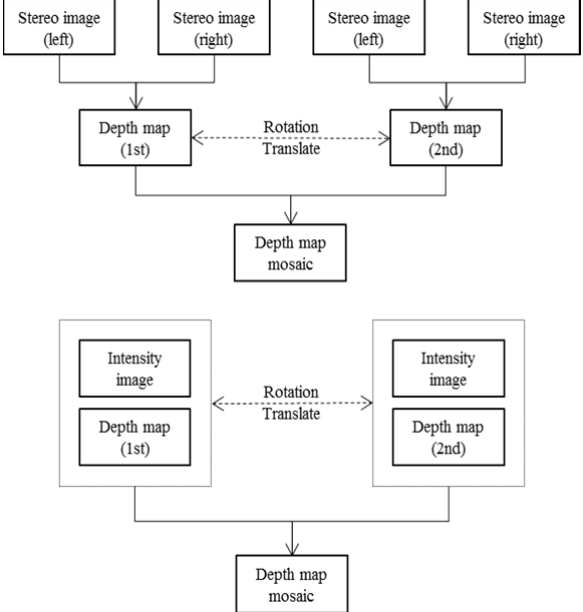
Figure 2. Process of mosaicking stereo images and depth